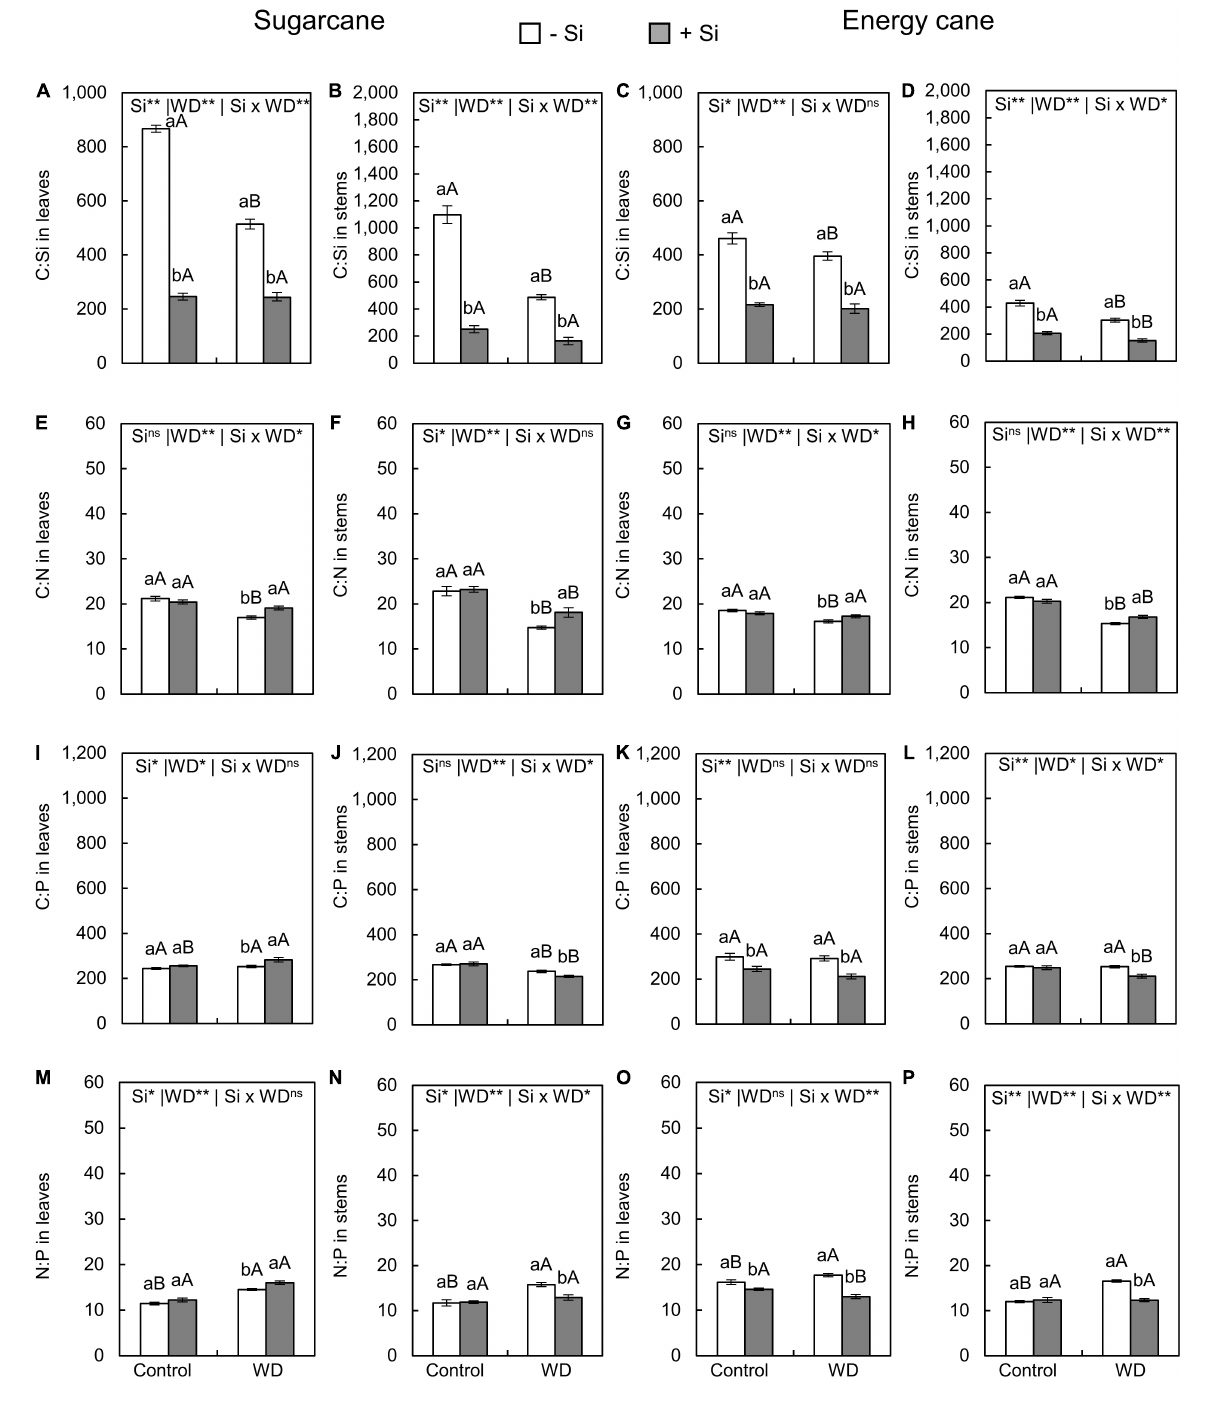
increased the water content in the leaf tissue of sugarcane ( Figures 7A , 8A ) and energy cane ( Figures 7B , 8B ) under control regime and WD compared to -Si.